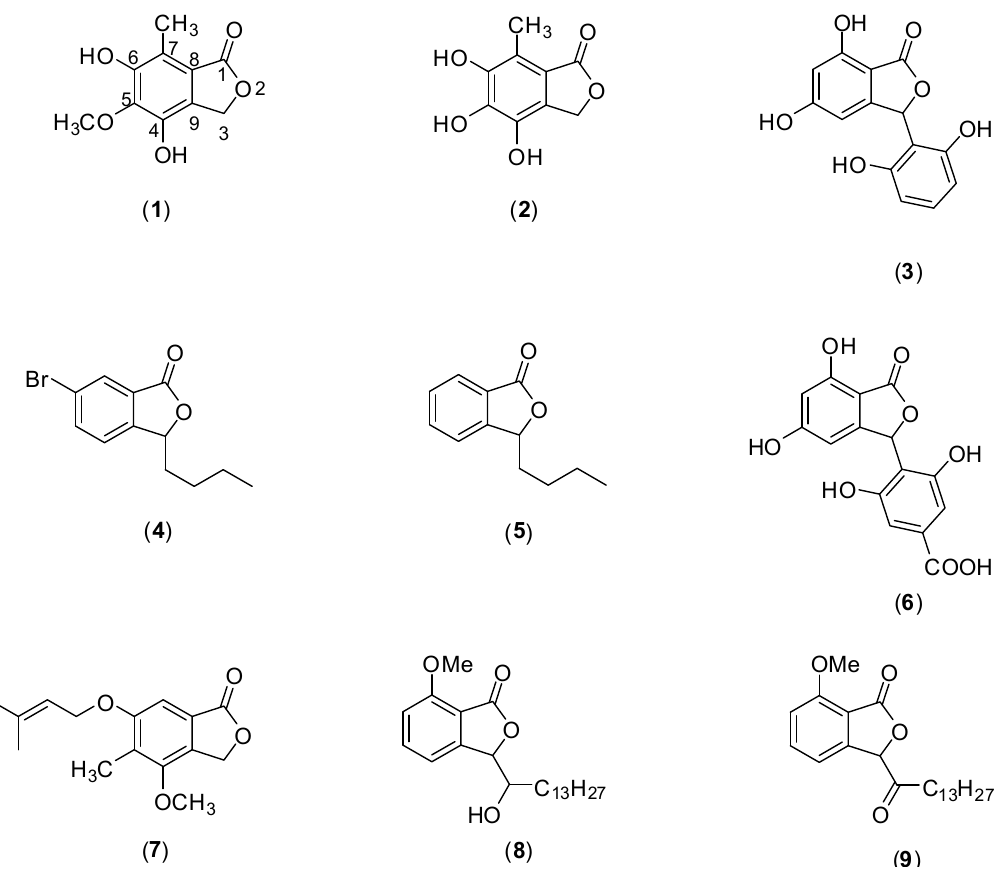
Figure 1. Structures of isobenzofuran-1( 3H )-ones 1 – 9